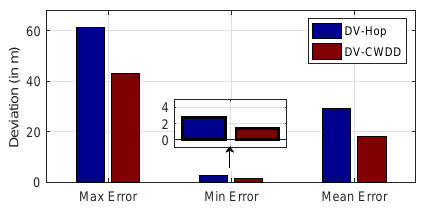
Figure 6. Comparison among maximum, minimum, and mean deviations.